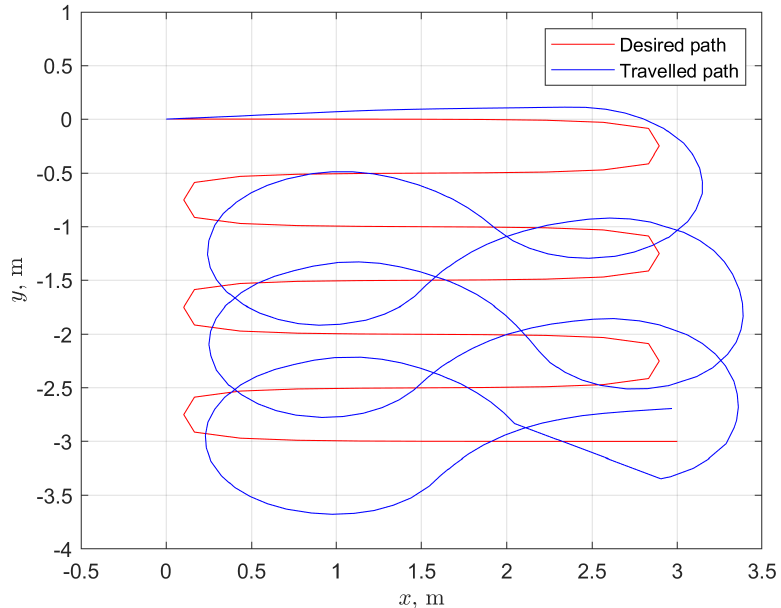
Figure 17. Desired path vs. actually traveled path for the highest value of the cost function equal to 1.2970—track